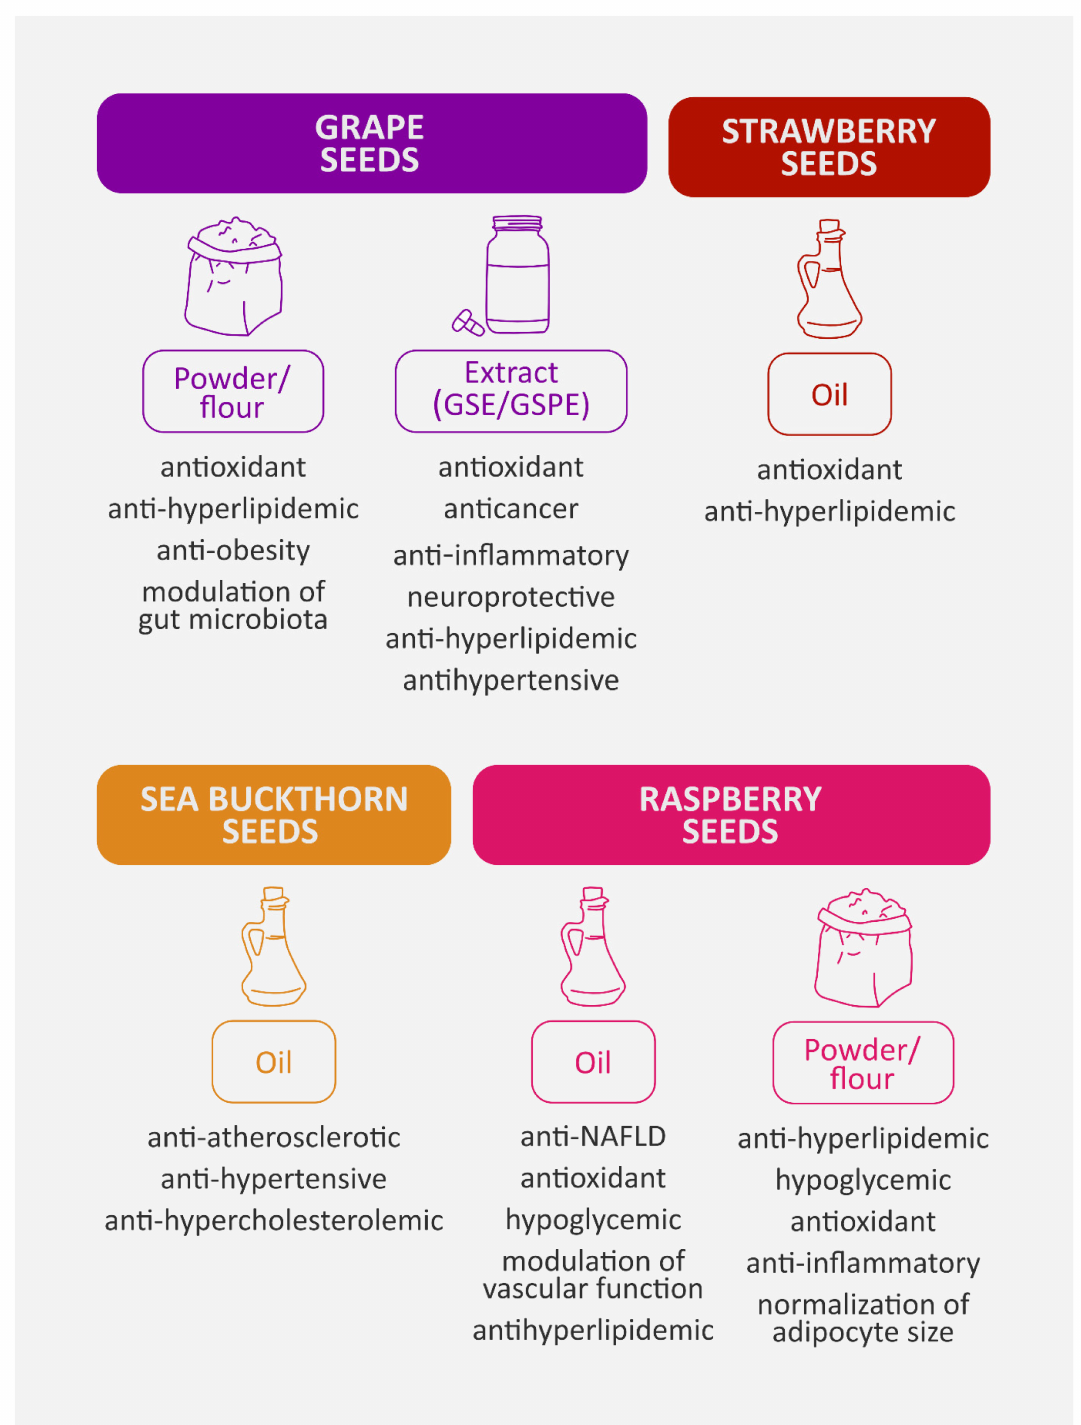
Figure 3. Selected food products from berry seeds and their biological activity. GSE—grape seed extract; GSPE—grape seed proanthocyanidin extract; NAFLD—non-alcoholic fatty liver disease. Compilation of data: